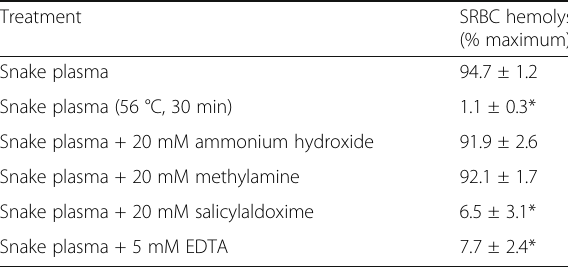
Table 1 Effects of heat, protease, and specific serum complement inhibitors on the hemolysis of sheep red blood cells (SRBCs) by plasma from Crotalus viridis